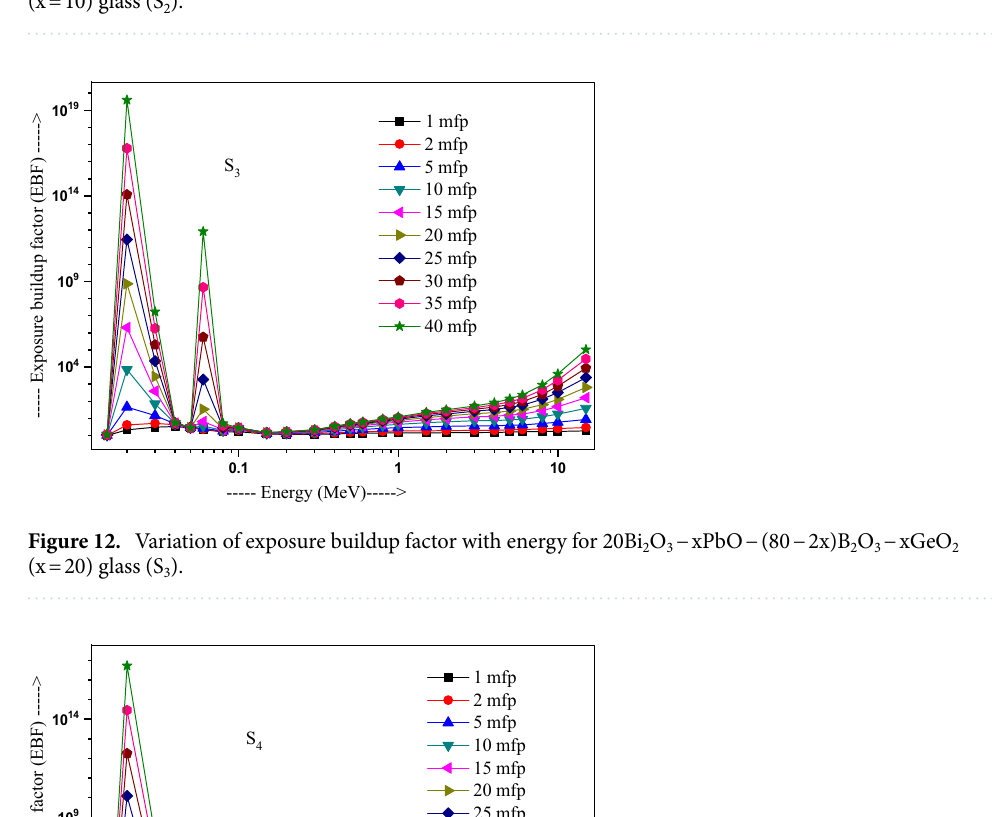
Figure 11. Variation of exposure buildup factor with energy for 20Bi 2 O 3 − xPbO − (80 − 2x)B 2 O 3 − xGeO 2 (x = 10) glass (S